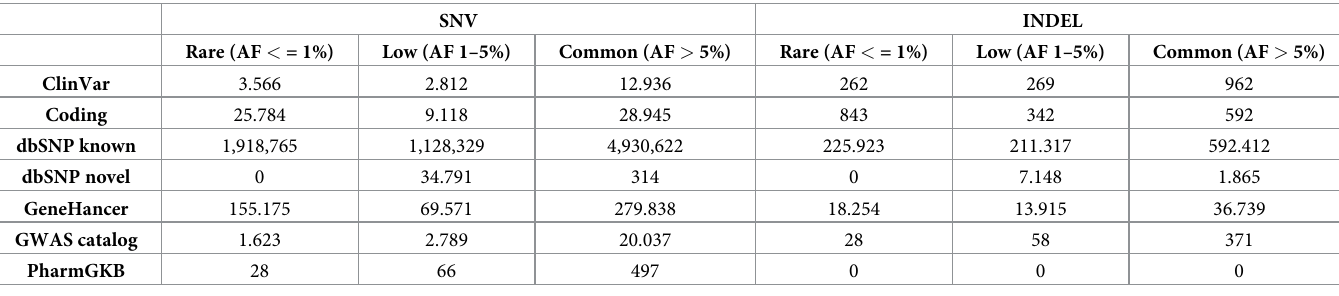
Table 1. NM whole genome variation